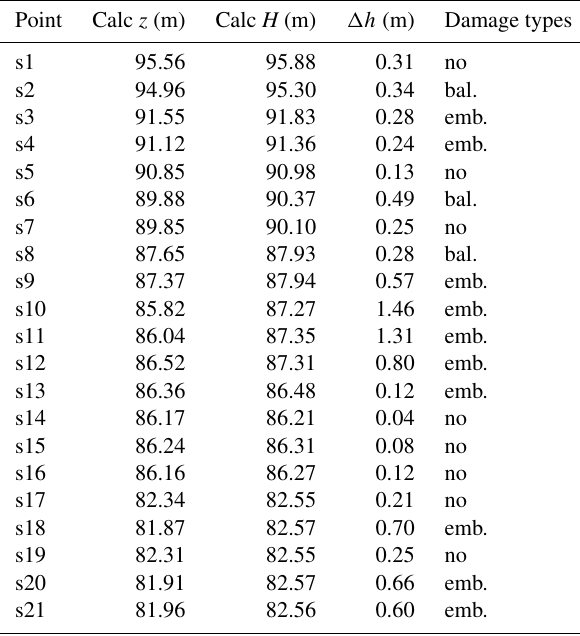
Table A2. Point-wise estimated overtopping water depth (cid:49)h and damage types for the Sayo River flood. Location of each point is indicated in Fig.